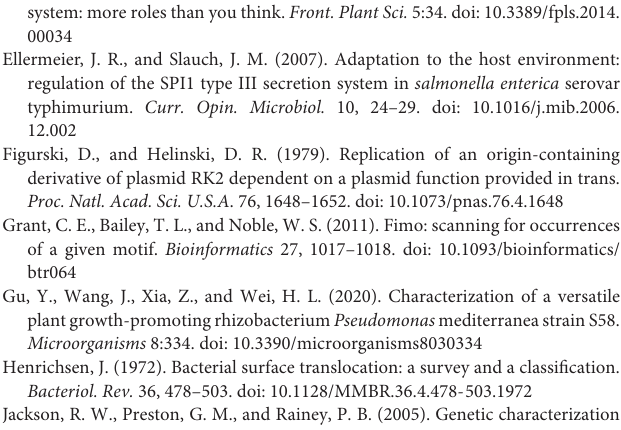
Figurski, D., and Helinski, D. R. (1979). Replication of an origin-containing derivative of plasmid RK2 dependent on a plasmid function provided in